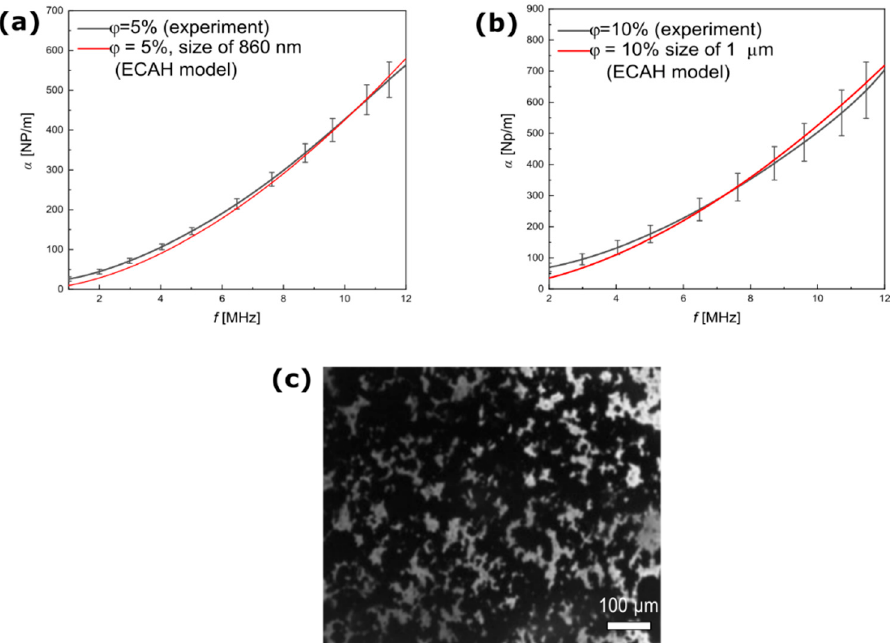
Figure 6. Experimental and theoretical results of the ultrasound attenuation of magnetite NPs dispersed in castor oil at different mass concentrations of particles: ( a ) 5% and ( b ) 10%. The theoretical curves were determined based on Equation (6) for the best-fitted sizes of particle scatterers. ( c ) Optical microscopy image of the dispersion of magnetite NP in castor oil (mass concentration at 10%).